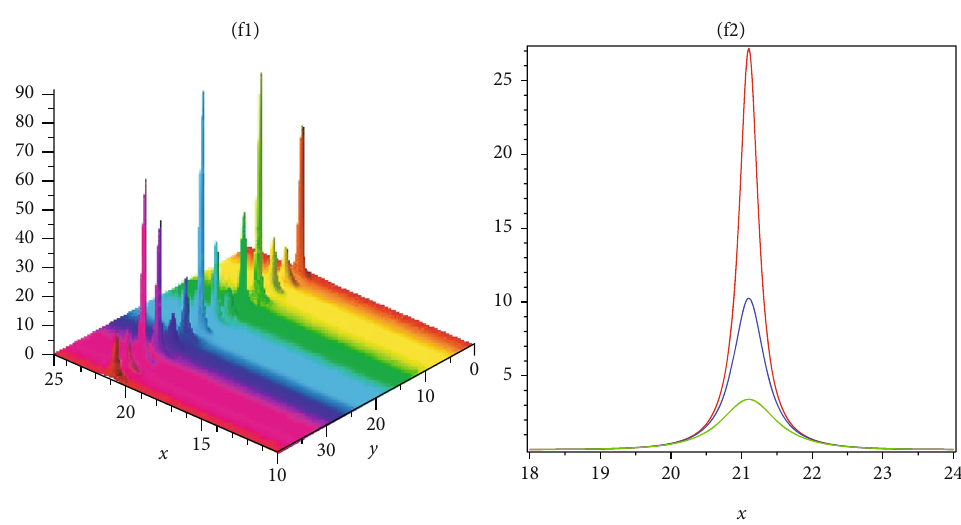
Figure 3: Graph of the absolute value of Eq. (24) for the ( 2 + 1 )-dimensional Benjamin-Ono equation at a = 2, α = 2, β = − 3, c = 2, γ = 2, r = 1, w = 0 : 3, t = 20 and for 2 plot spaces y = − 10, − 7, 1 .